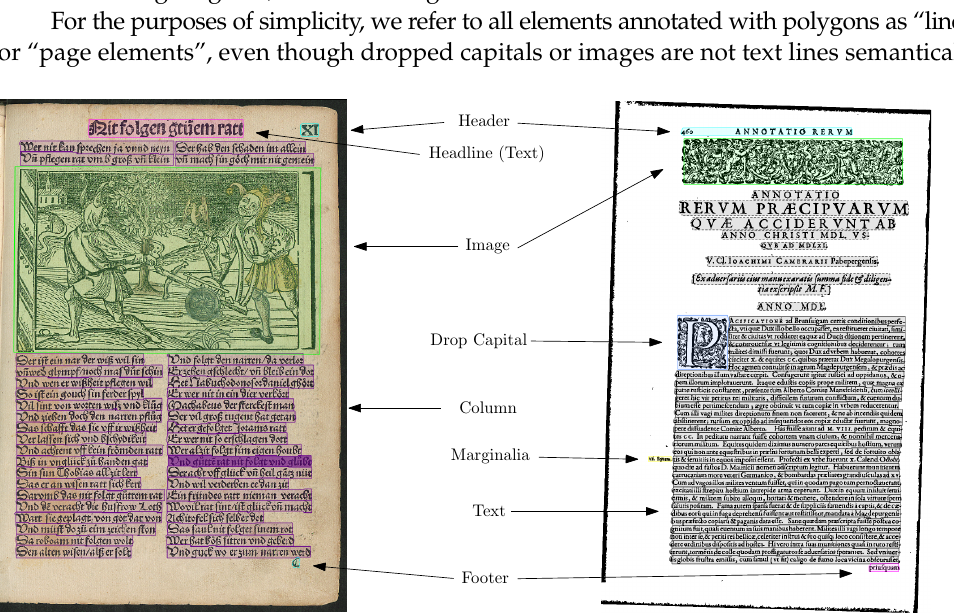
Figure 3. Page element types distinguished in the datasets. Text lines in the page header are classified as “header” lines (blue in the case of folio numbers); the main text lines or headlines of the page are classified as “text” (grey, pink); catchwords and signature marks are classified as “footer” (magenta); dropped capitals (blue) and marginalia (yellow) are classified